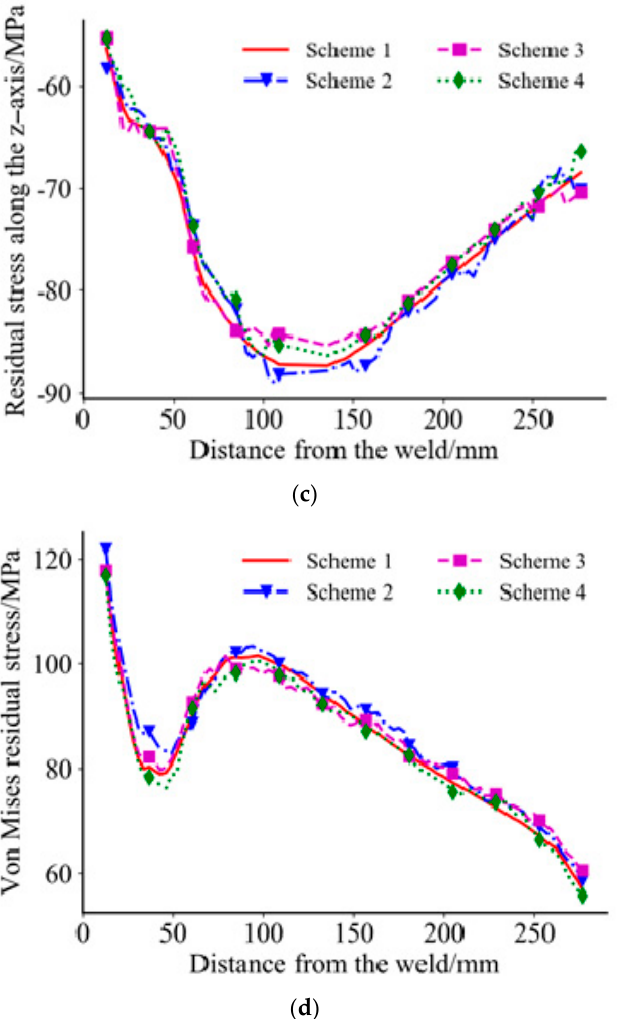
Figure 8. Comparison of residual stress in the vertical direction of the vertical plate: ( a ) residual stress along the x-axis; ( b ) residual stress along the y-axis; ( c ) residual stress along the z-axis; ( d ) von Mises residual stress.